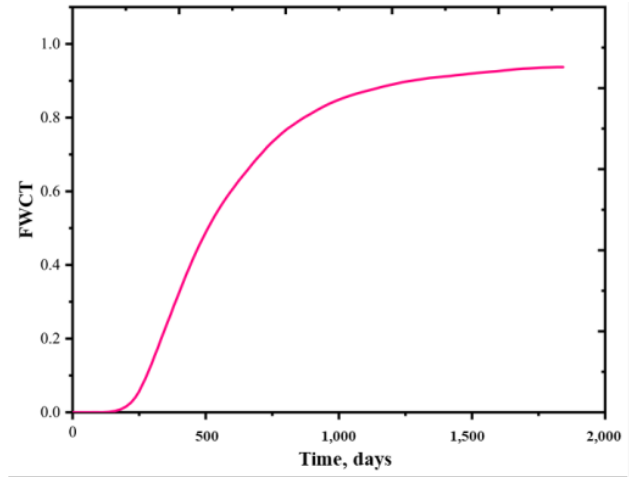
Figure 11. Field water cut for horizontal wells.